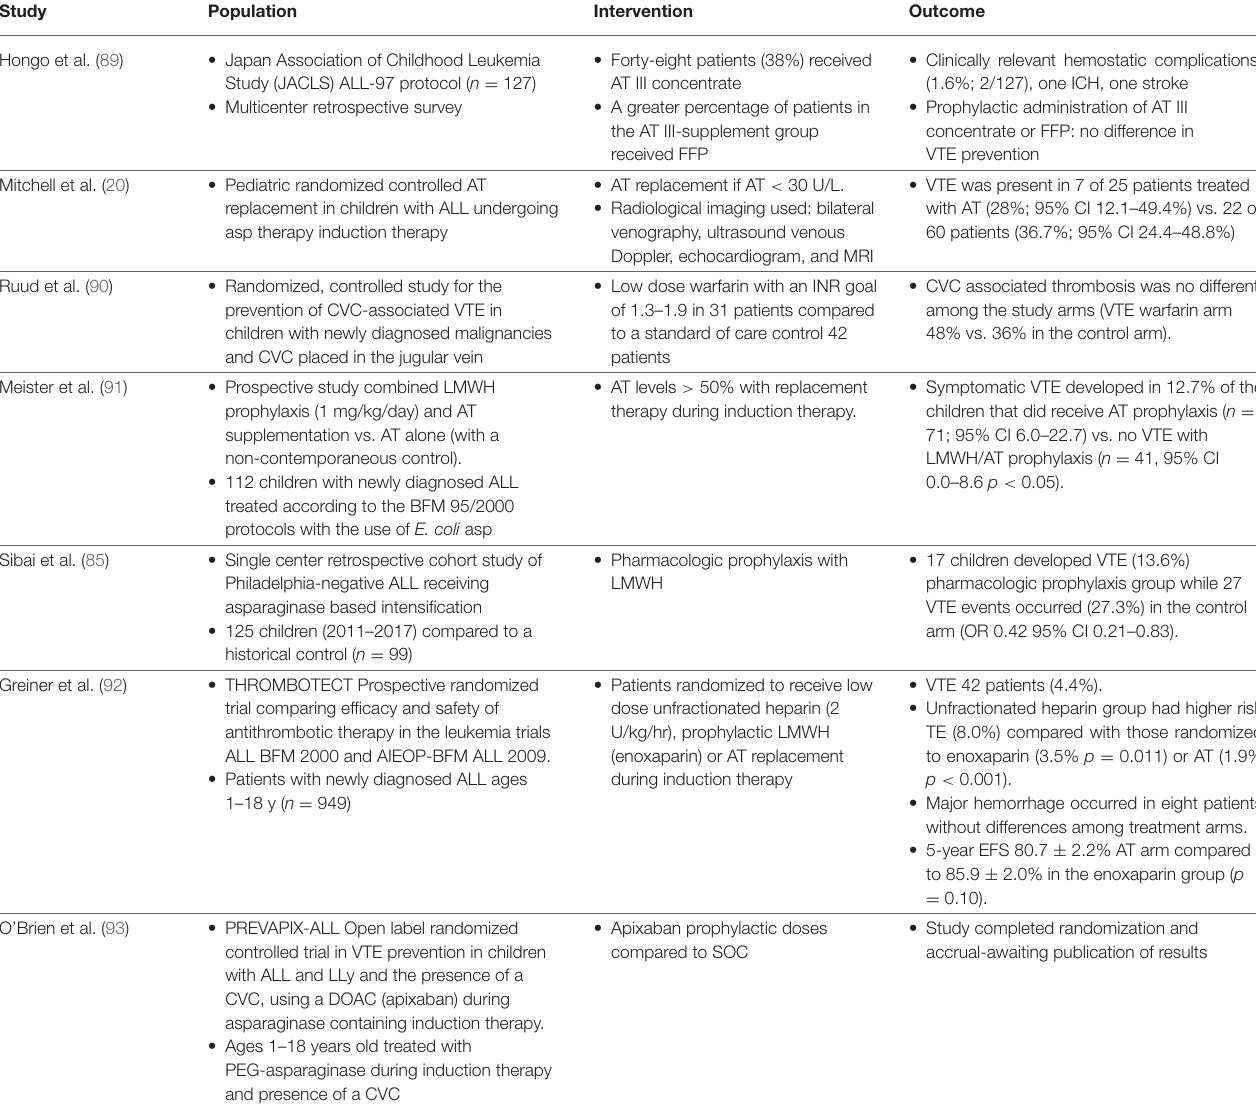
TABLE 1 | Summary of VTE prevention in pediatric ALL and other oncologic diagnoses.